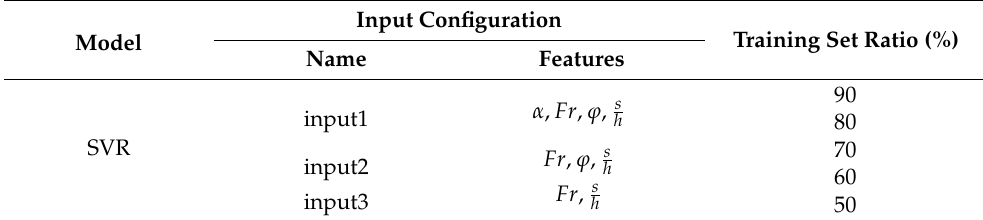
Table 2. Input combinations of SVR.